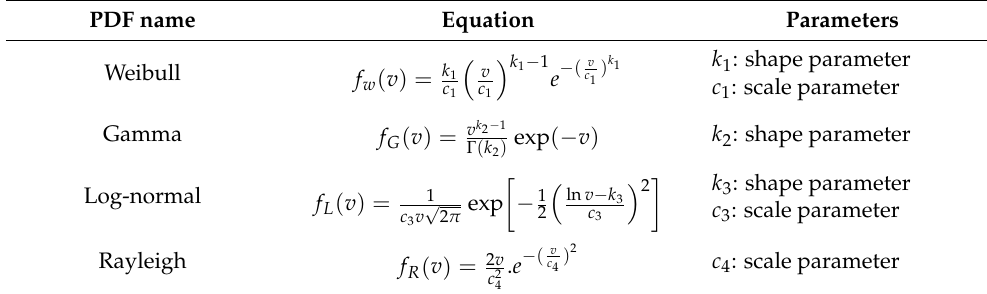
Table 1. Probability density